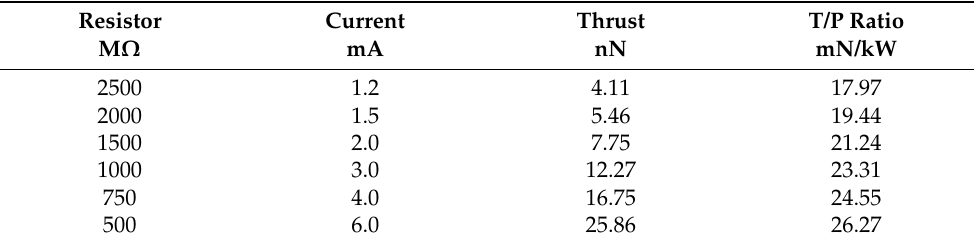
Table 2. Simulation results for the study of the influence of discharge current in the single-stage argon EHD thruster by varying the ballast resistor for a fixed applied voltage of 3 kV.